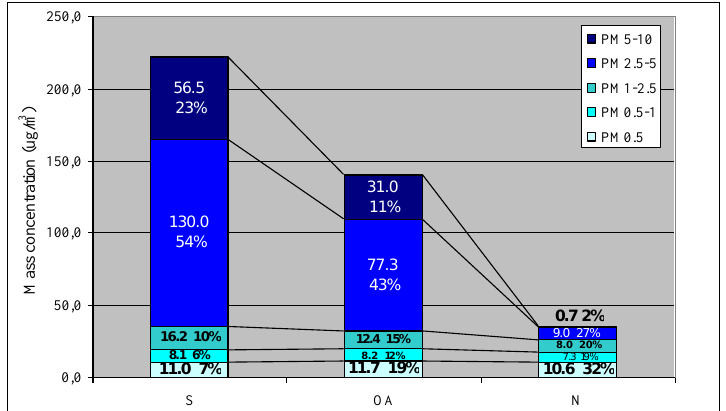
Figure 5. Mean contributions of the size-fractioned PM (PM PM ) to the 5-d PM 5–10 in the